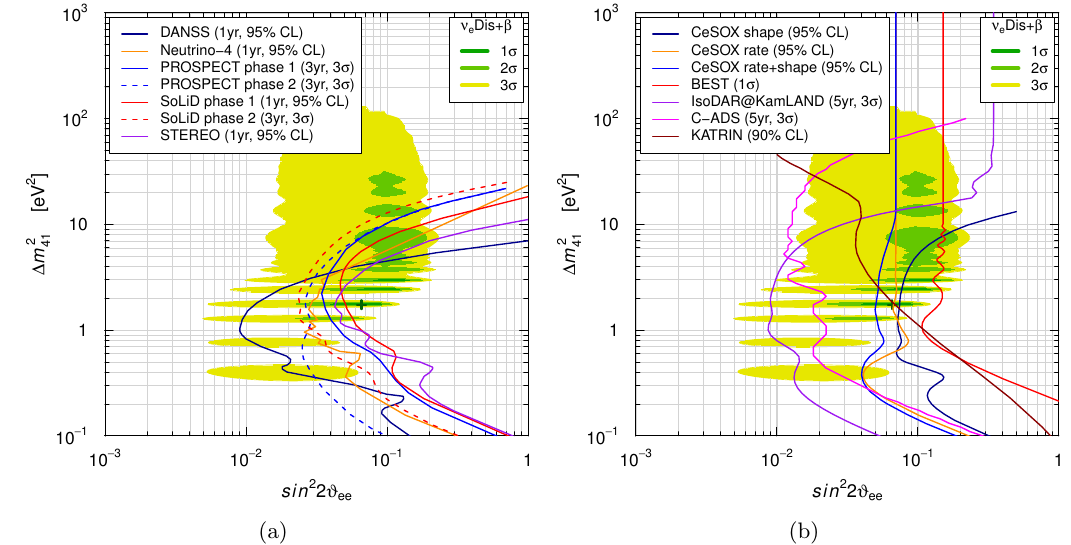
Figure 6 . Sensitivities of future reactor (a) and source (b) experiments compared with the allowed regions in the sin 2 2 # ee {(cid:1) m 2 plane in (cid:12)gure 41